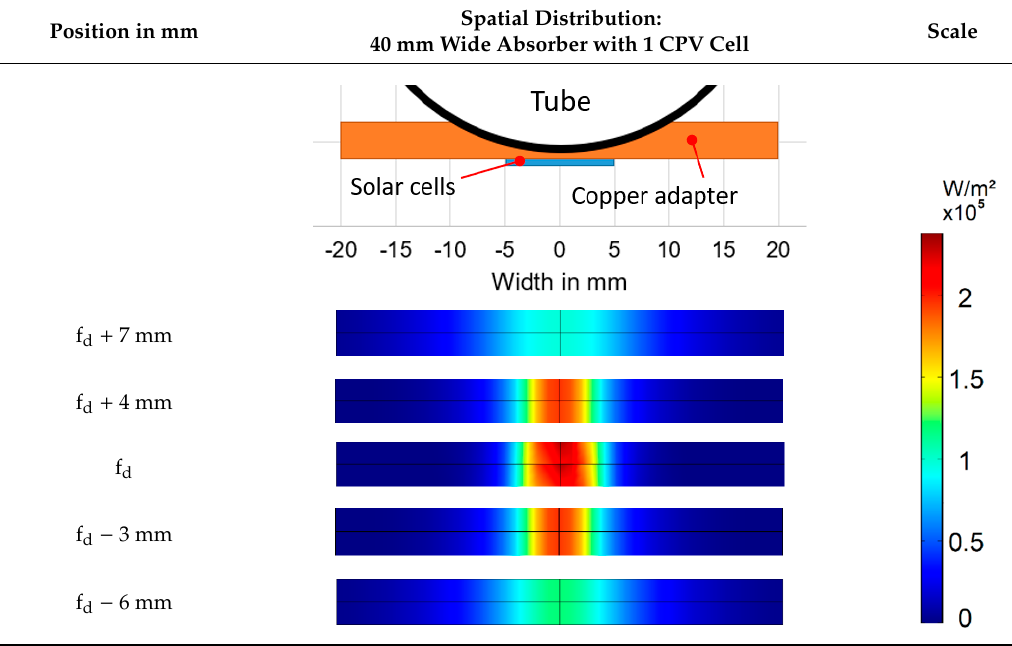
Figure 9. ( a ) Shows the spatial distribution of different receiver positions in the possible high concentration setup . ( b ) Depicts the to ( a ) associated simulation setup, where the focal point f d is located and how the absorber tube is positioned. Table 3. Ray tracing simulation of the concentrator parabolic mirror setup to show the influence of the receiver’s (CPV cell’s) position on peak flux and flux distribution of the high concentration setup.